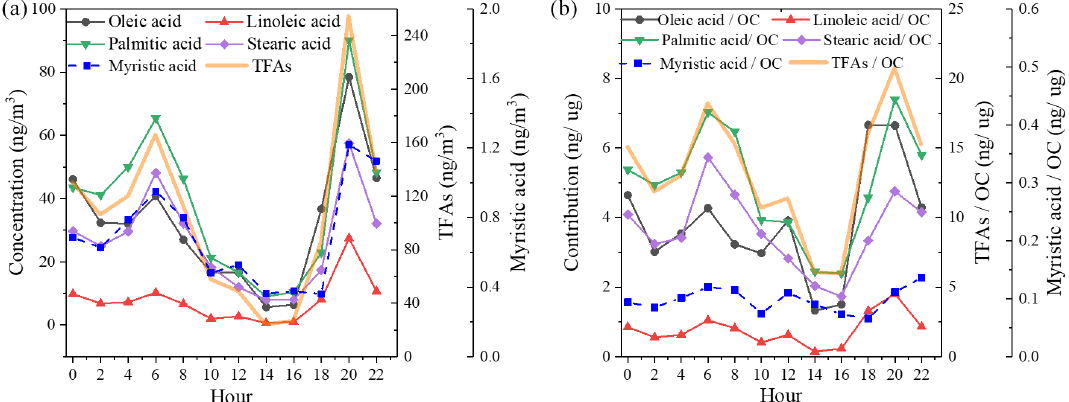
Figure 3. Diurnal variation in five fatty acids and TFAs during the observation